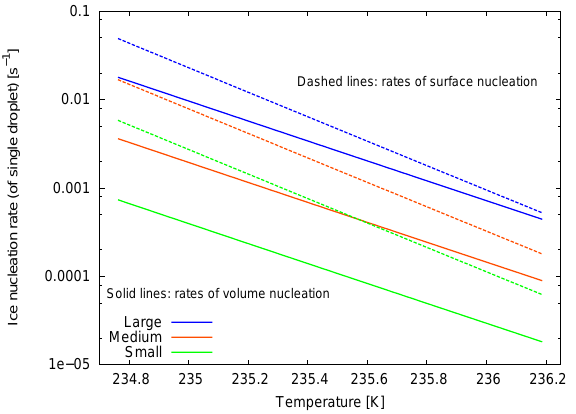
Fig. 3. Total nucleation rate for one droplet as a function of its radius. Contributions from freezing events in the bulk volume or at the surface are shown as dashed and dotted lines which intersect at r c . For droplets with radii smaller than r c nucleation at the surface is more probable. The sum of these contributions is the total rate, J t .